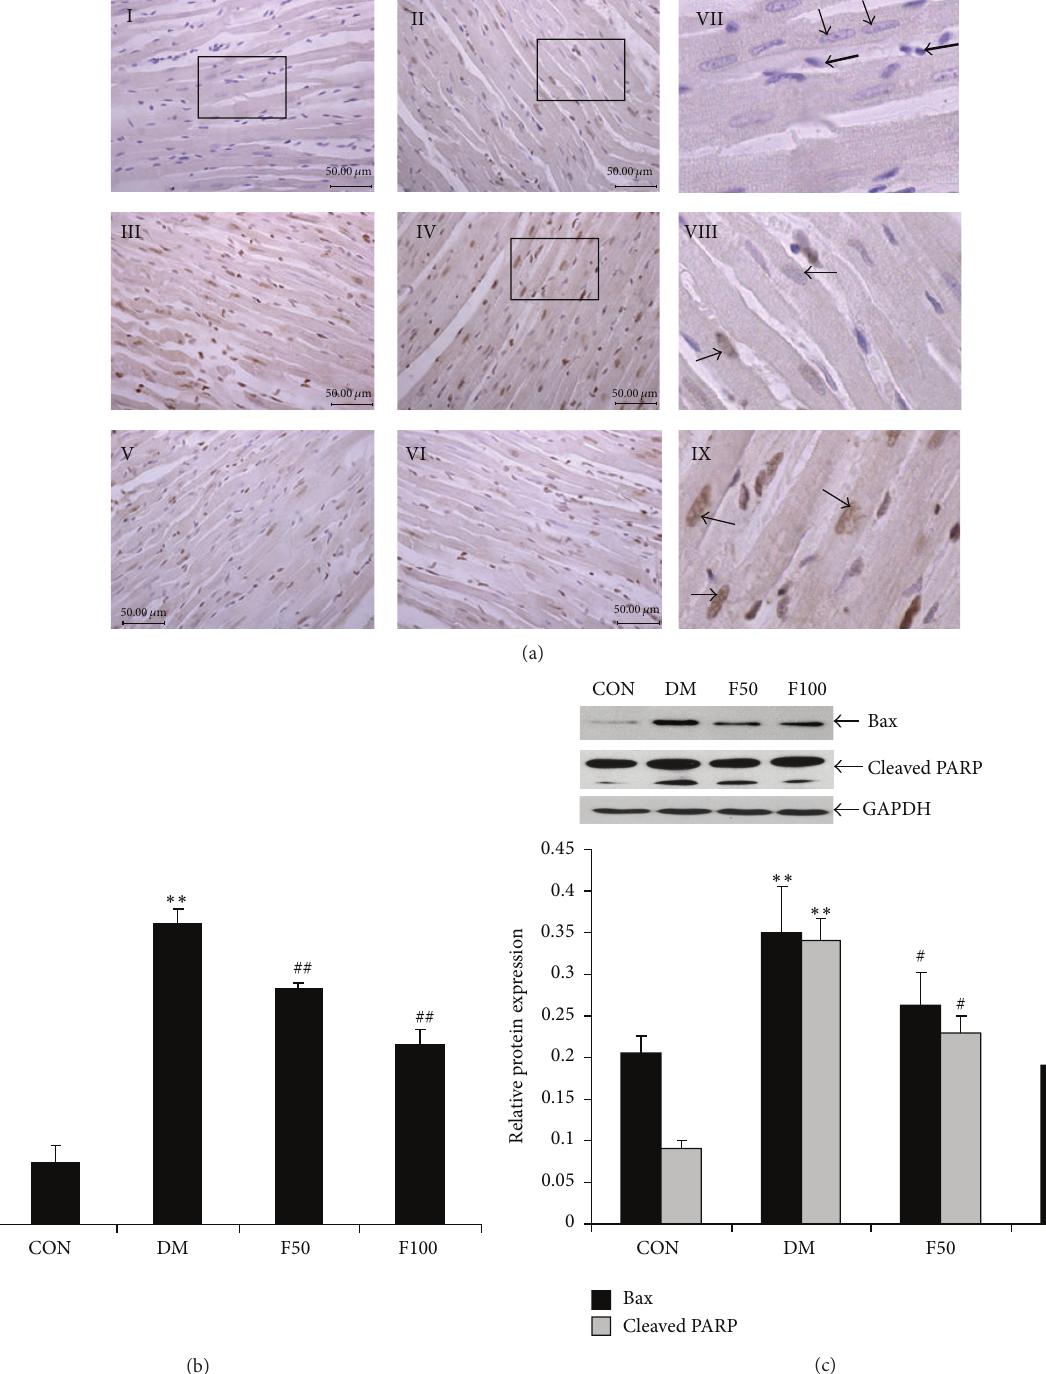
Figure 4: LMWF reduced apoptosis in the cardiac tissue of diabetic GK rats. (a) Representative micrographs of the TUNEL assay. I represents negative control group without TUNEL reaction mixture, II represents control group, III and IV represent DM group, and V and VI represent diabetic rats administered with 50 and 100 mg/kg/day LMWF, respectively (scale bar = 50 𝜇 m, 𝑁 = 3 in each group). The black lined-boxes (in I,II,andIV)wereshownbyhigh-magnificationmicrographsofVII,VIII,andIX,respectively.Boldarrowsshowthenucleiofbloodcellswhile thin arrows show the nuclei of cardiomyocytes. (b) Statistical analysis of the percentage of apoptotic cells in each group by randomly selected 9 fields from each micrograph. (c) Western blots showing the expression of Bax and PARP in heart tissues of each group. The densitometry value of Bax and cleaved PARP was normalized to that of GAPDH and data are presented as the mean ± SEM. The statistical analysis was performed. ∗∗ 𝑃 < 0.01 versus control group; # 𝑃 < 0.05 , ## 𝑃 < 0.01 versus DM group. 𝑁 = 9 in each